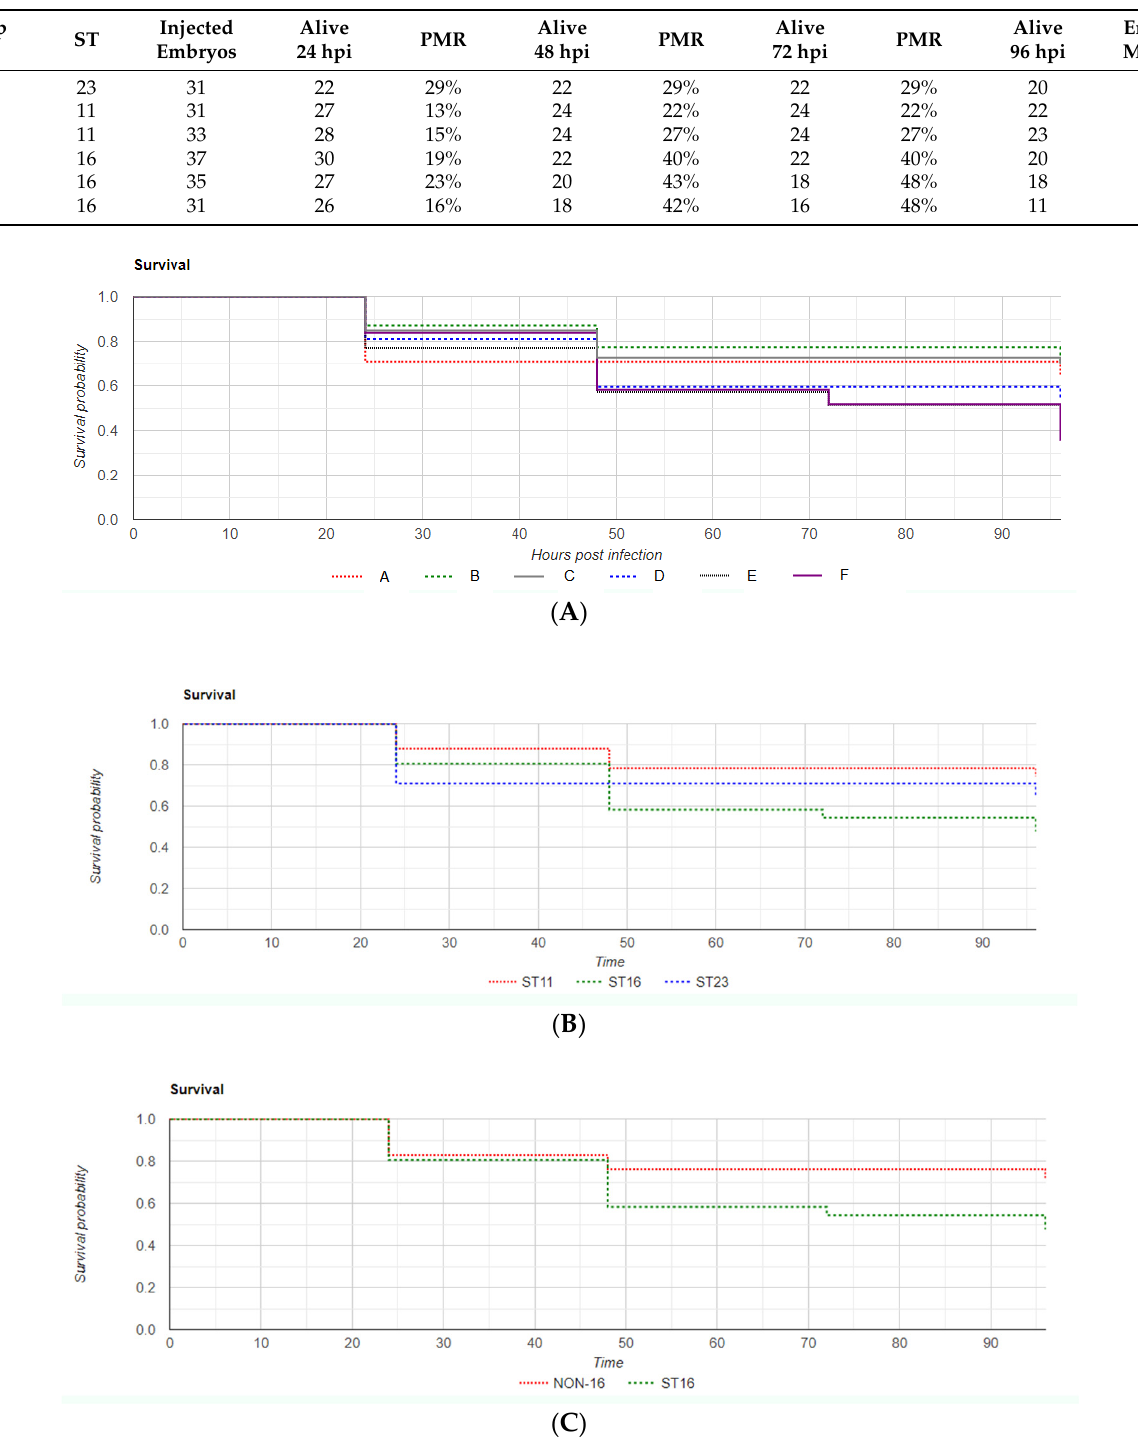
Figure 2. Overall zebrafish Kaplan–Meier survival curve ( A ) according to K. pneumoniae strain of infection; ( B ) Kaplan–Meier curves when grouping survival of embryos by ST of infection; ( C ) Kaplan–Meier survival curves comparing zebrafish infection by K. pneumoniae ST16 strains with non-ST16 strains. Time is expressed in hours post-infection (hpi).